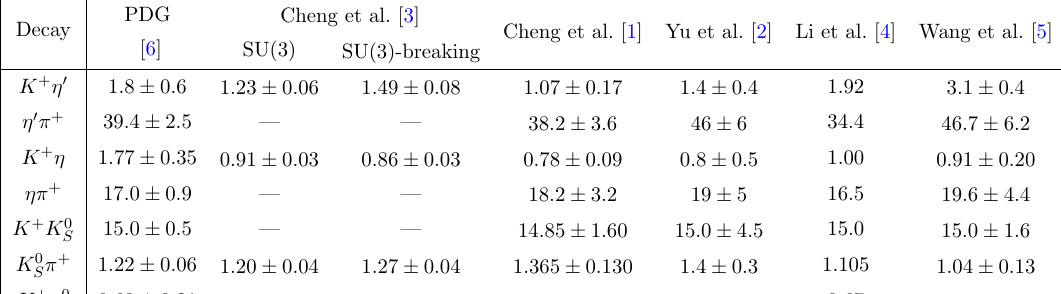
Table 1 . Comparisons of the D + decay BFs between the world average results from PDG [6] and s calculations from di(cid:11)erent theoretical models (in unit of 10 (cid:0) 3 ).